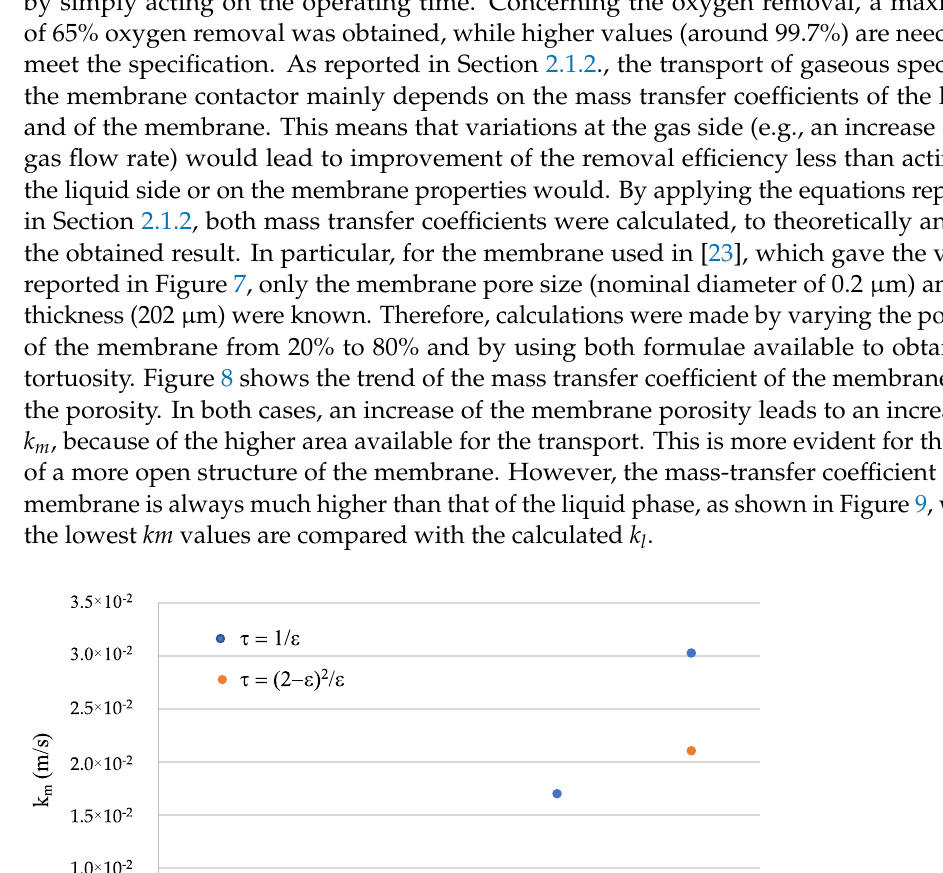
Figure 7. Maximum variations registered in [23] for the seawater pre-treatment.